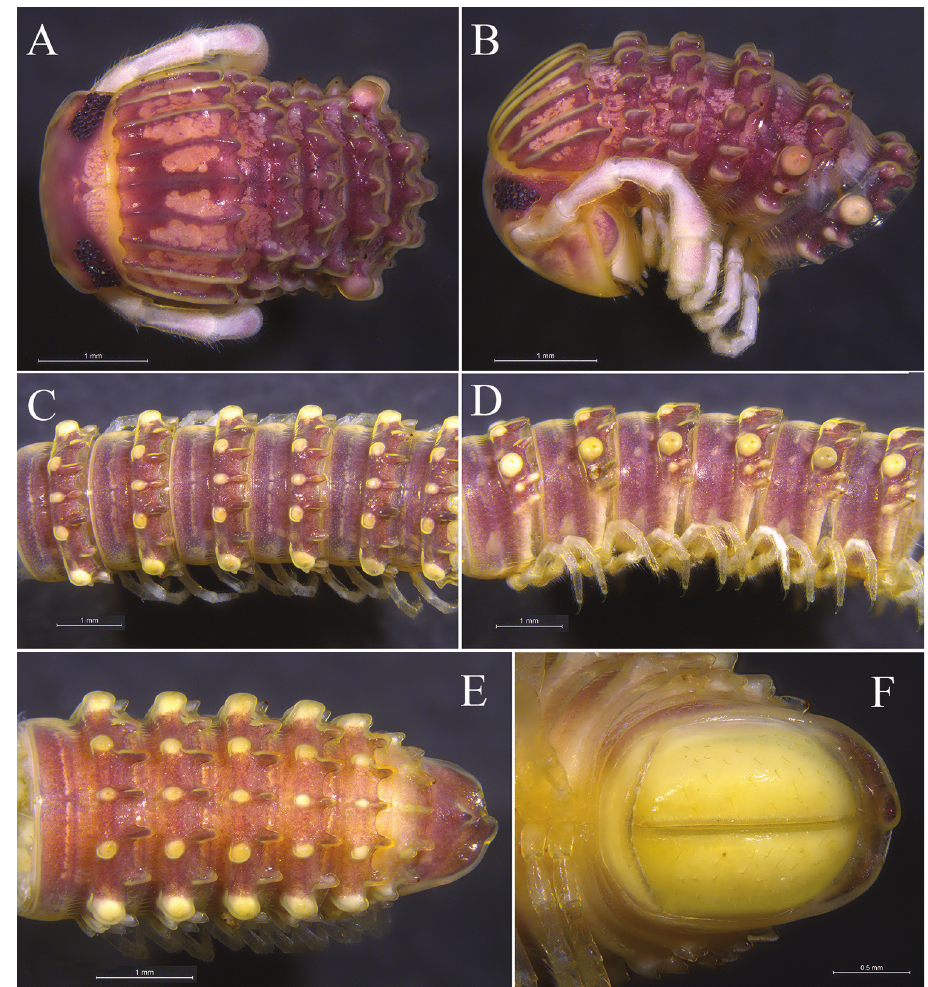
Figure 2. Glyphiulus foetidus sp. n., holotype. A anterior part of body, dorsal view B same, lateral view C mid- body segments, dorsal view D same, lateral view E posterior part of body, dorsal view F same, ventral